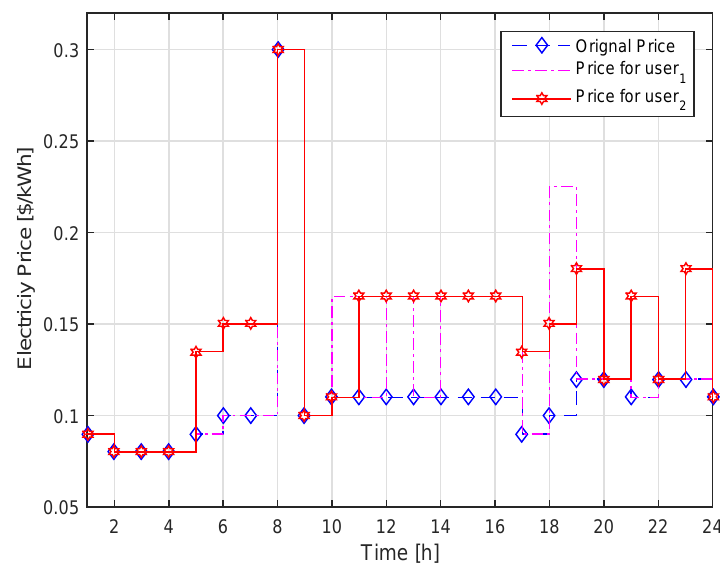
Figure 4. Pricing signal for each individualized user obtained by LBPP.